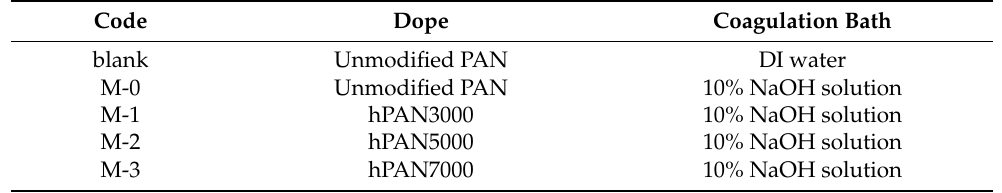
Table 1. Preparation conditions of